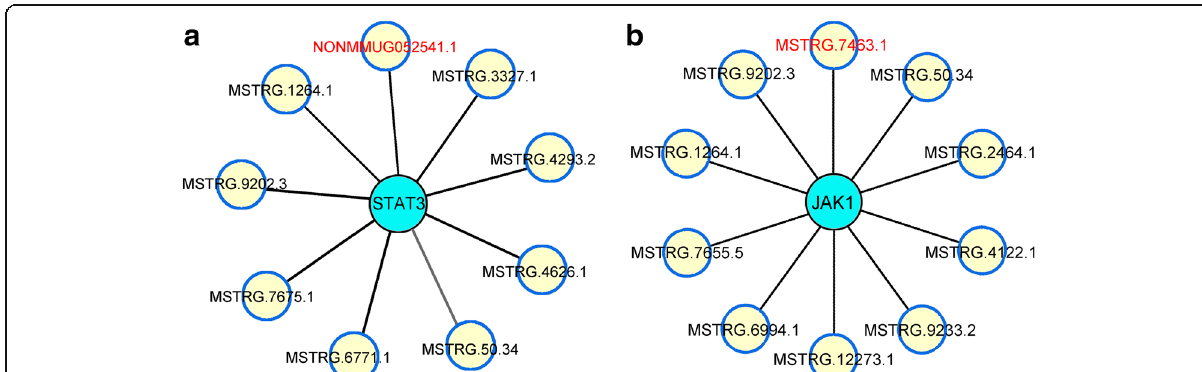
Fig. 8 Co-expressed lncRNAs with JAK1 and STAT3. a Nine lncRNAs, NONMMUG052541.1, MSTRG.1264.1, MSTRG.3327.1 MSTRG.4293.2, MSTRG.4626.1, MSTRG.50.34, MSTRG.6771.1, MSTRG.7675.1, MSTRG.9202.3, co-expressed with STAT3. Among these lncRNAs, NONMMUG052541.1 had the highest co-expressed degrees with STAT3. b Ten lncRNAs, MSTRG.7463.1, MSTRG.50.34, MSTRG.2464.1, MSTRG.4122.1, MSTRG.9233.2, MSTRG.12273.1, MSTRG.6994.1, MSTRG.7655.5, MSTRG.1264.1, MSTRG.9202.3, co-expressed with JAK1. Among these lncRNAs, MSTRG.7463.1 had the highest co-expressed degrees with